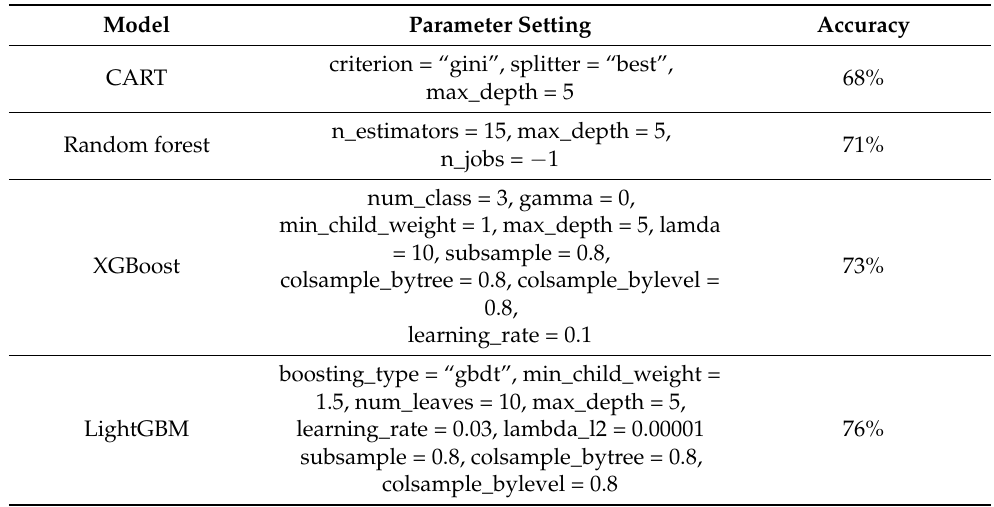
Table 2. Single model parameter setting and prediction accuracy.